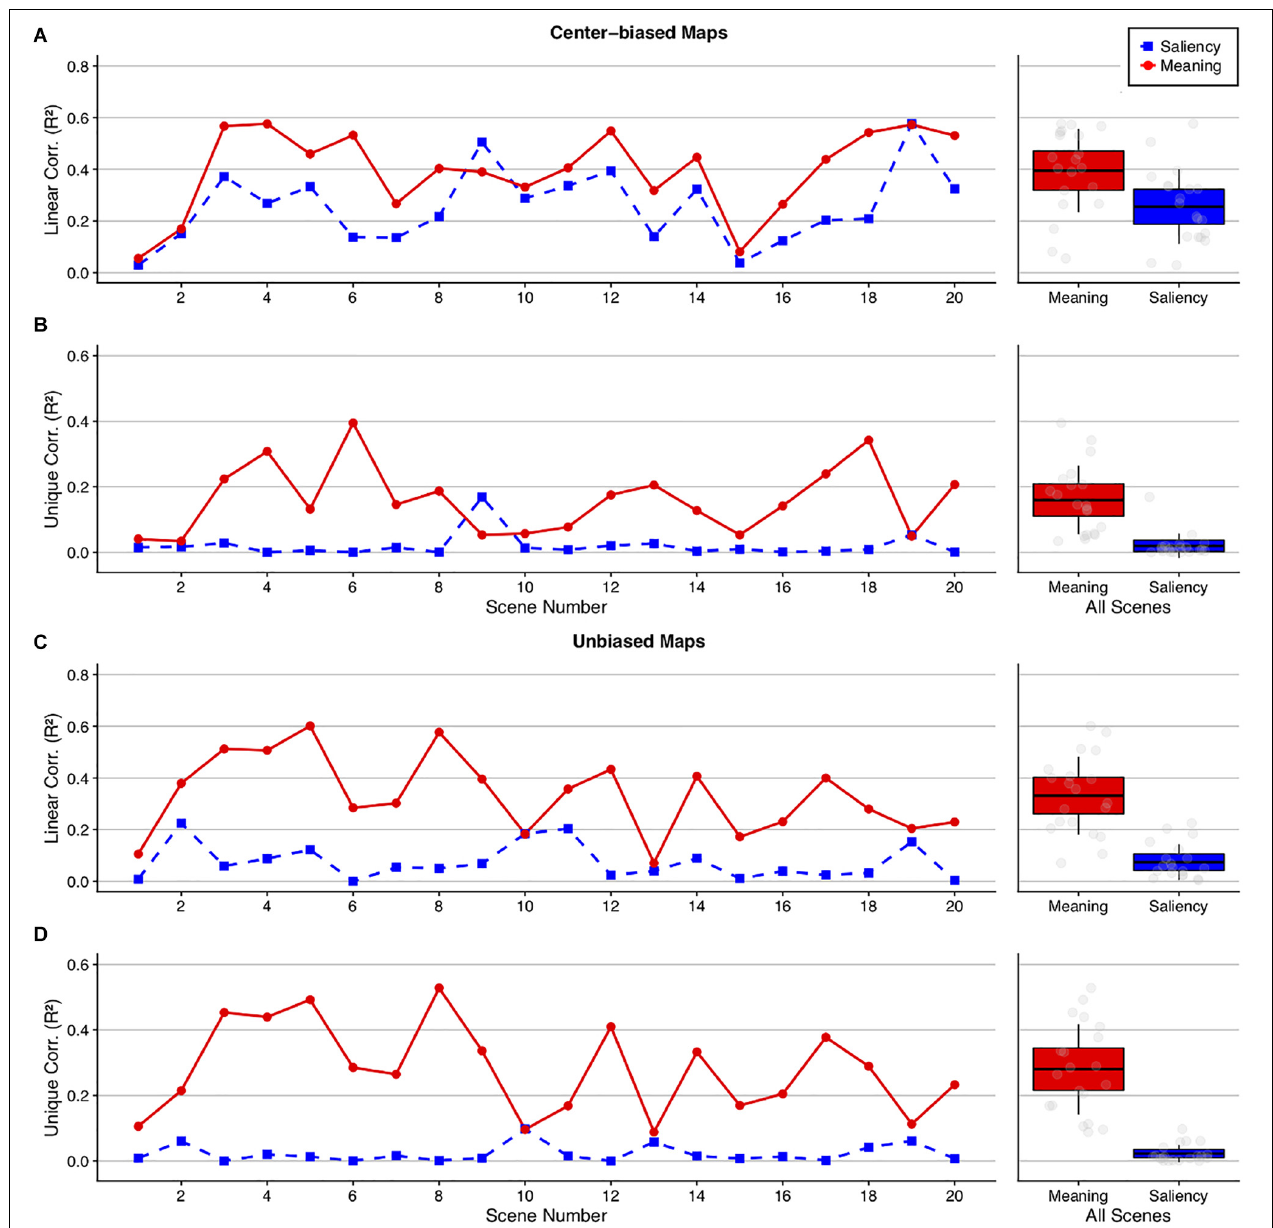
FIGURE 5 | Squared linear and semi-partial correlations by scene comparing meaning and image salience. Line plots show the (A,C) squared linear and (B,D) semi-partial correlations between the fixation density maps, meaning (red circles), and image salience (blue squares) using (A,B) center-biased and (C,D) unbiased prediction maps. The scatter plots show the grand mean (black horizontal line), 95% confidence intervals (colored boxes), and 1 standard deviation (black vertical line), for meaning and image salience across all 20 scenes for each